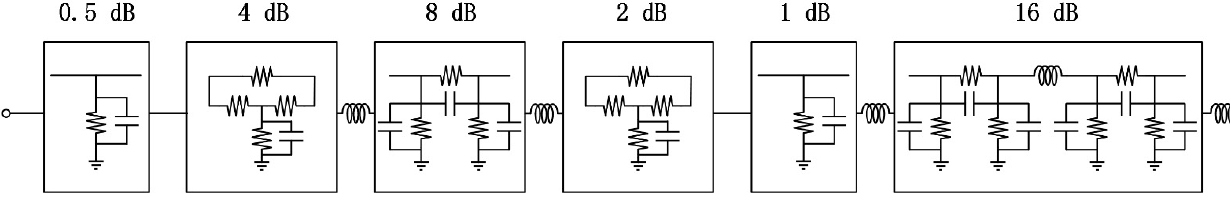
Figure 1. The diagram of the proposed attenuator circuit with the switches neglected.